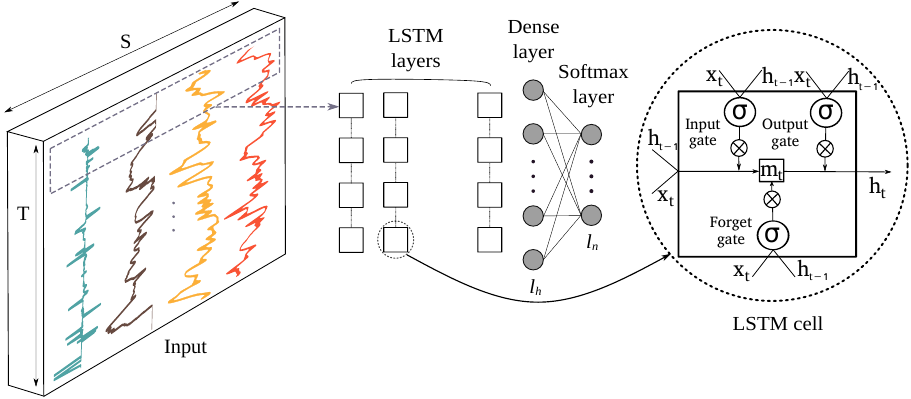
Figure 5. Architecture of a LSTM network for accident detection . The designations n , h and S are the number of classes, layers and sensor channels, respectively. The cells in the LSTM layers have one input, forget and output gates. x t , m t and h t refer to the cell input, memory, and output at time t , respectively, and σ designates the activation function.